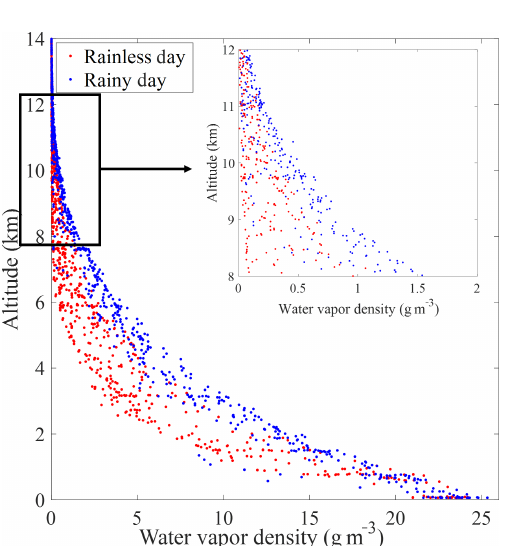
Figure 15. Changes in water vapour density with altitude in dif- ferent weather conditions; data are from radiosonde measurements (blue for rainy days from 12 to 18 June 2017 and red for rainless days from 13 to 19 August